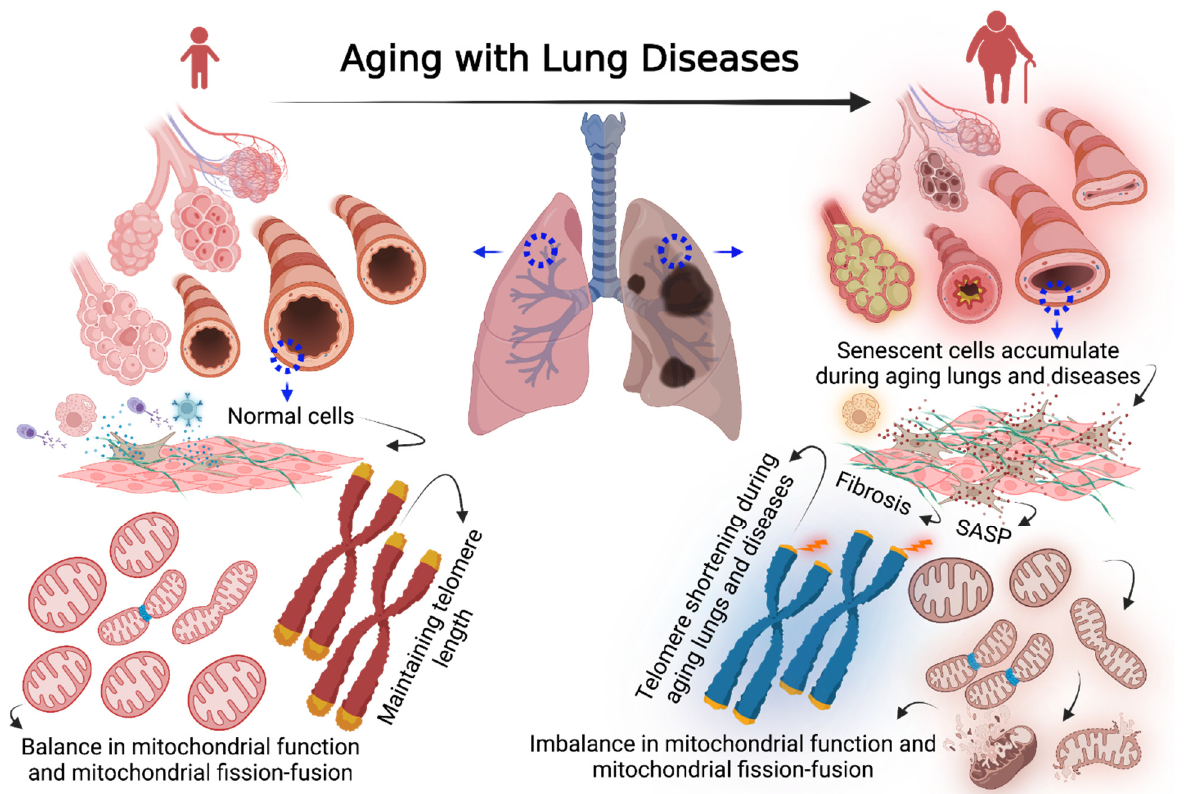
Figure 1. Left schematic figure shows a normal lung of young age with a low number of senescent cells rapidly cleared by immune cells, normal cells maintain a baseline of telomere length and mitochondrial homeostasis. Right schematic figure shows aged and diseased lung associated with increased fibrosis, higher numbers of senescent cells, and slow response of immune cells to clear senescent cells. Senescent cells are characterized by telomere shortening, secreting high rates of SASP, mitochondrial dysfunction, and an imbalance in mitochondrial fission and fusion. Figure 1 was created with BioRender.com accessed on 24 April